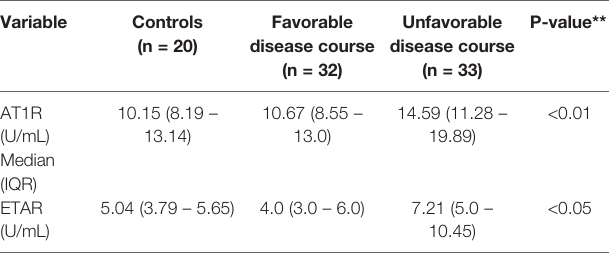
TABLE 1B | Titers of AT1R and ETAR in subgroups, with median and interquartile range (IQR).